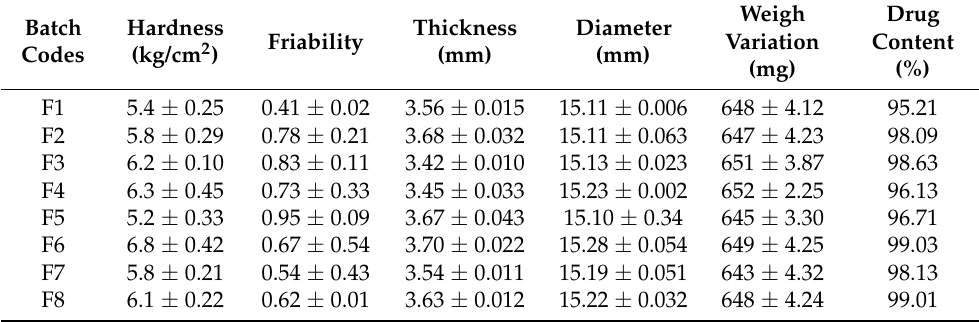
Table 5. Physico-chemical parameters of metronidazole effervescent